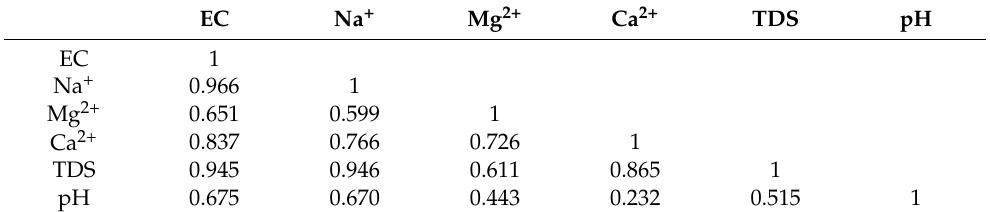
Table 1. Correlation matrix from raw